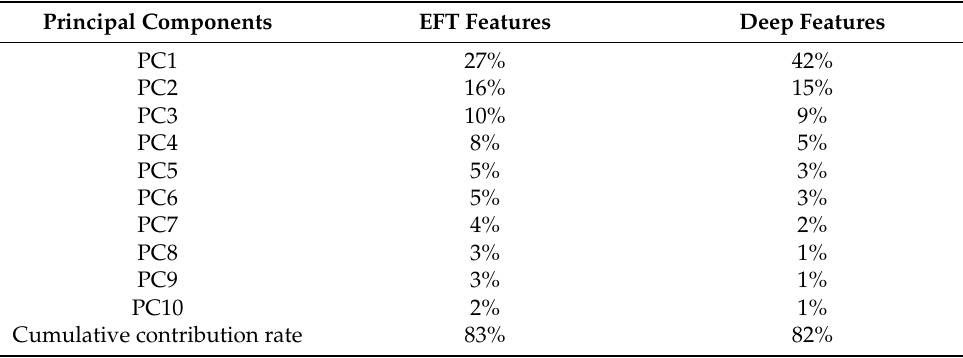
Table 2. Contribution rates of different principal